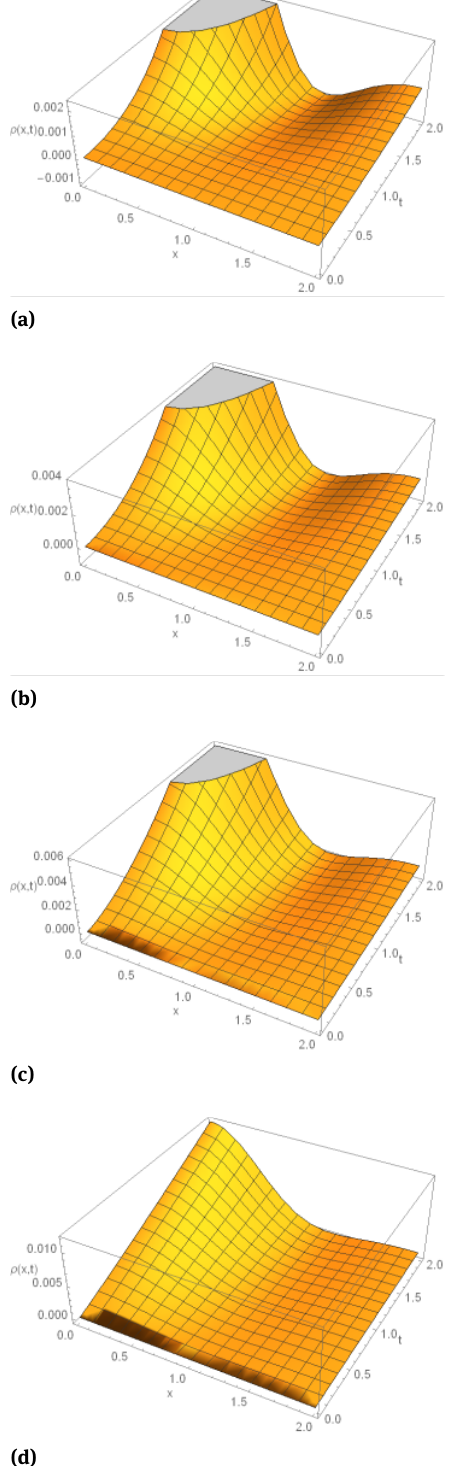
Figure 5: The surface graph of approximate solution v ( x , t ) and ρ ( x , t ) for β = 1 : (a) v ( x , t ) for case-I (b) ρ ( x , t ) for case-I (c) v ( x , t ) for case-II (d) ρ ( x , t ) for